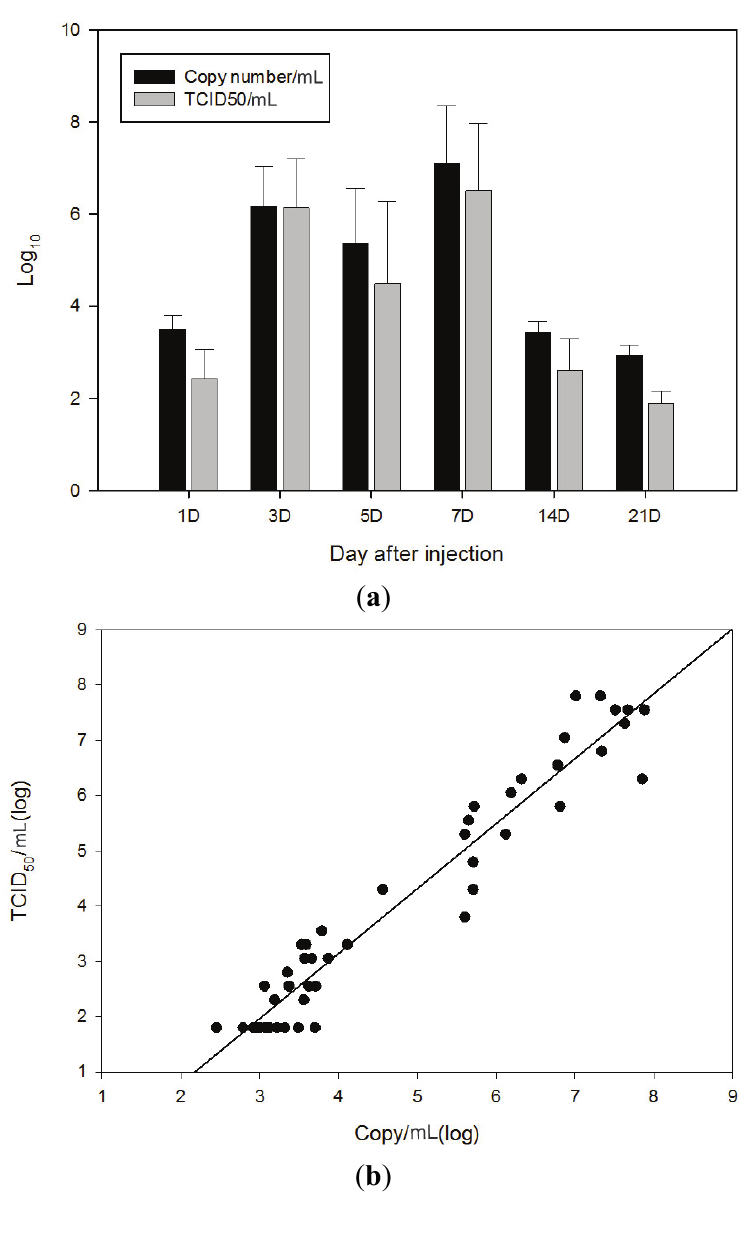
Figure 3. Comparison of VHSV titer (TCID /mL) and copy number ( in vivo ). ( a ) Black 50 bar indicates average log values of the VHSV copy number and gray bar indicates average log values of VHSV titer (TCID /mL); ( b ) The copy numbers of VHSV determined from 50 qRT-PCR versus those from VHSV titer (TCID /mL) for individual 50